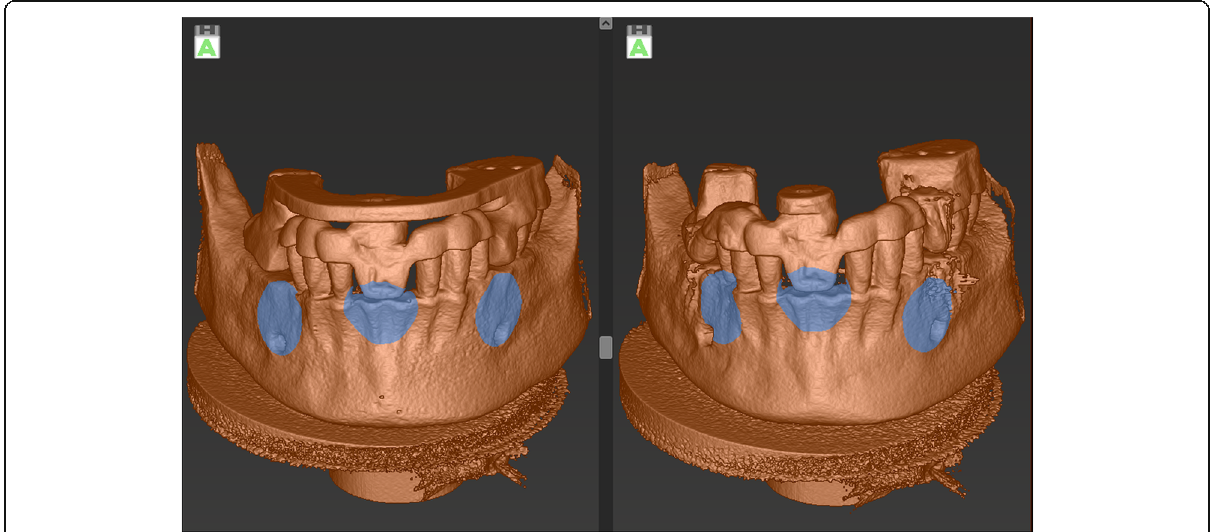
Fig. 2 Superimposition of the pre-operative scan (left image) and the post-operative scan of the mandibular model with the attached template. The gray circular areas are depicting the region in which both scans are matched to each other